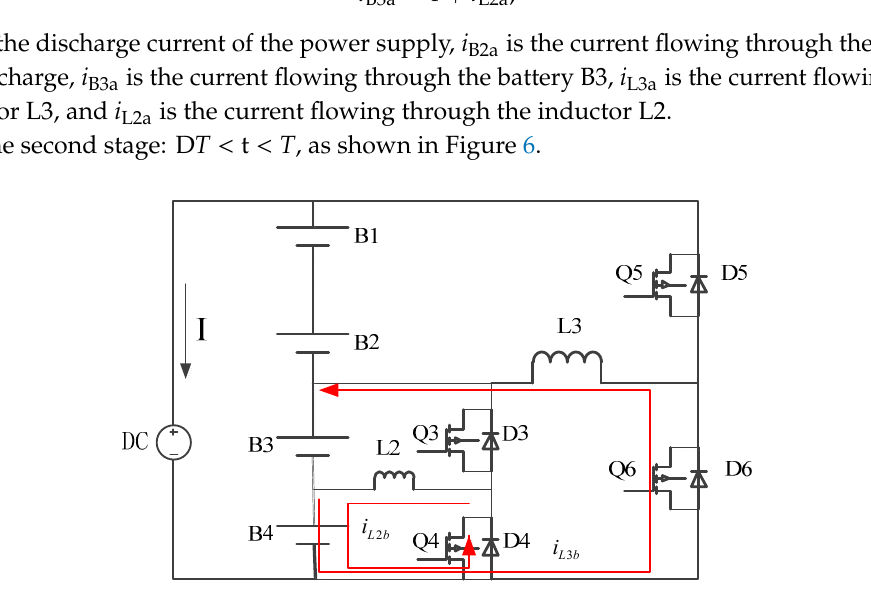
Figure 5. Schematic of the first stage of discharge equalization.